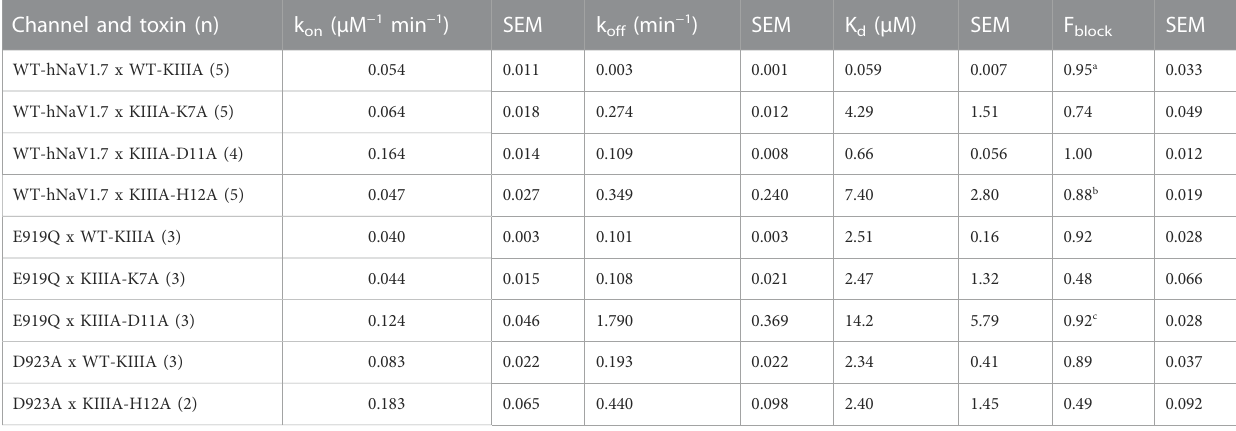
TABLE 3 Block of double-mutant cycle pairs of hNa V 1.7 and KIIIA. Channel and toxin (n)